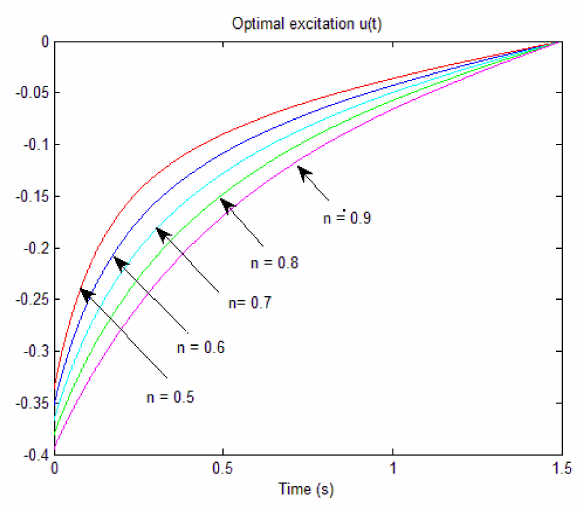
Figure 8. Optimal excitation ˆ u ( t )